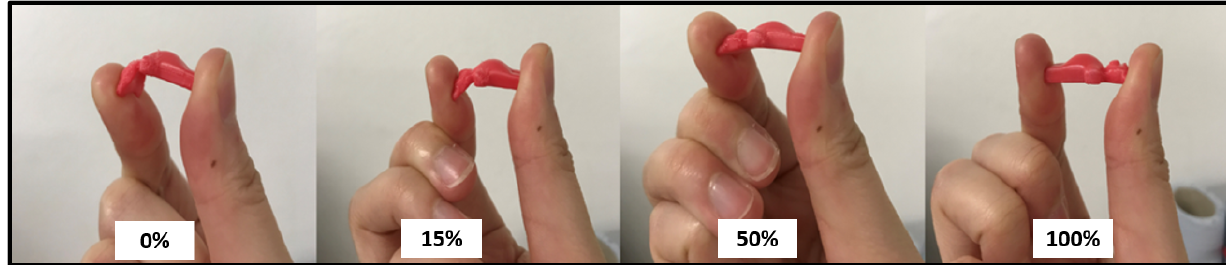
Figure 4. Design 4 (i.e., gummy bear shape) remotely 3D ‐ printed at 0%, 15%, 50%, and 100% infill